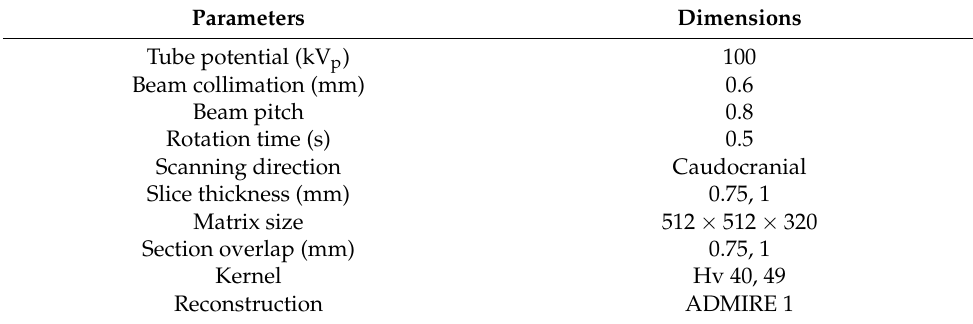
Table 1. Scan parameters of cerebral non-contrast CT and contrast